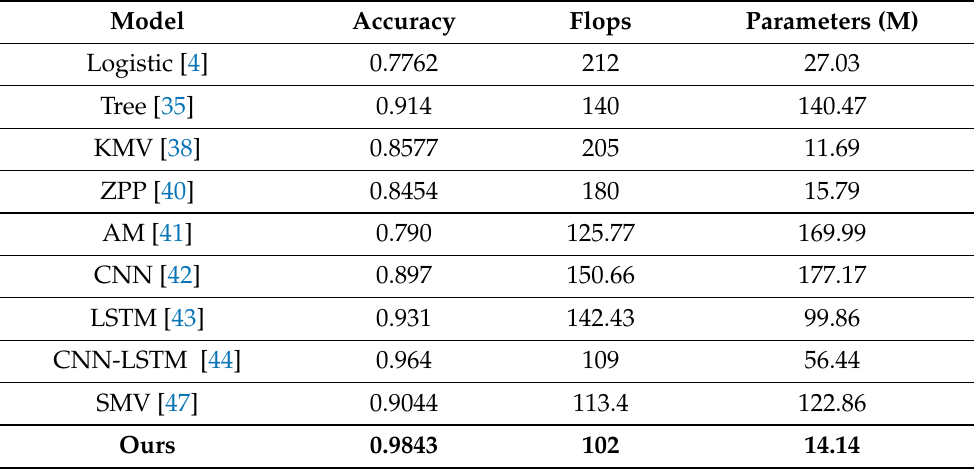
Table 5. A comparison of different